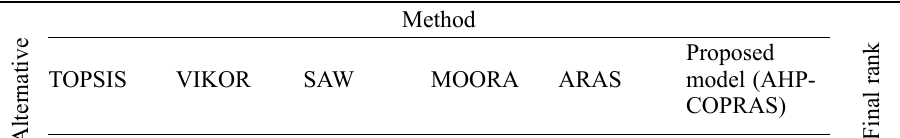
nk Proposed a model (AHP- r